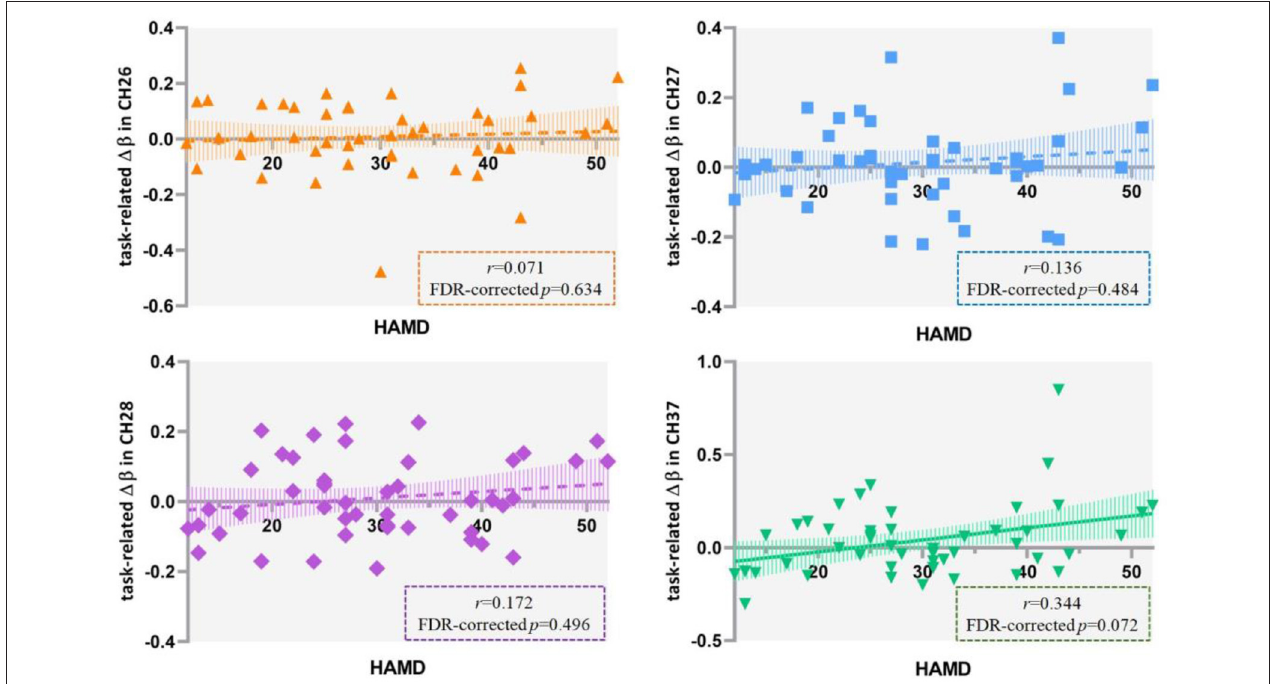
FIGURE 6 | Correlation between HAMD scores and the VFT-related 1 β ( β post − β pre ) in 47 patients with major depressive disorder. HAMD, Hamilton Depression Rating Scale-24; VFT, verbal fluency task.